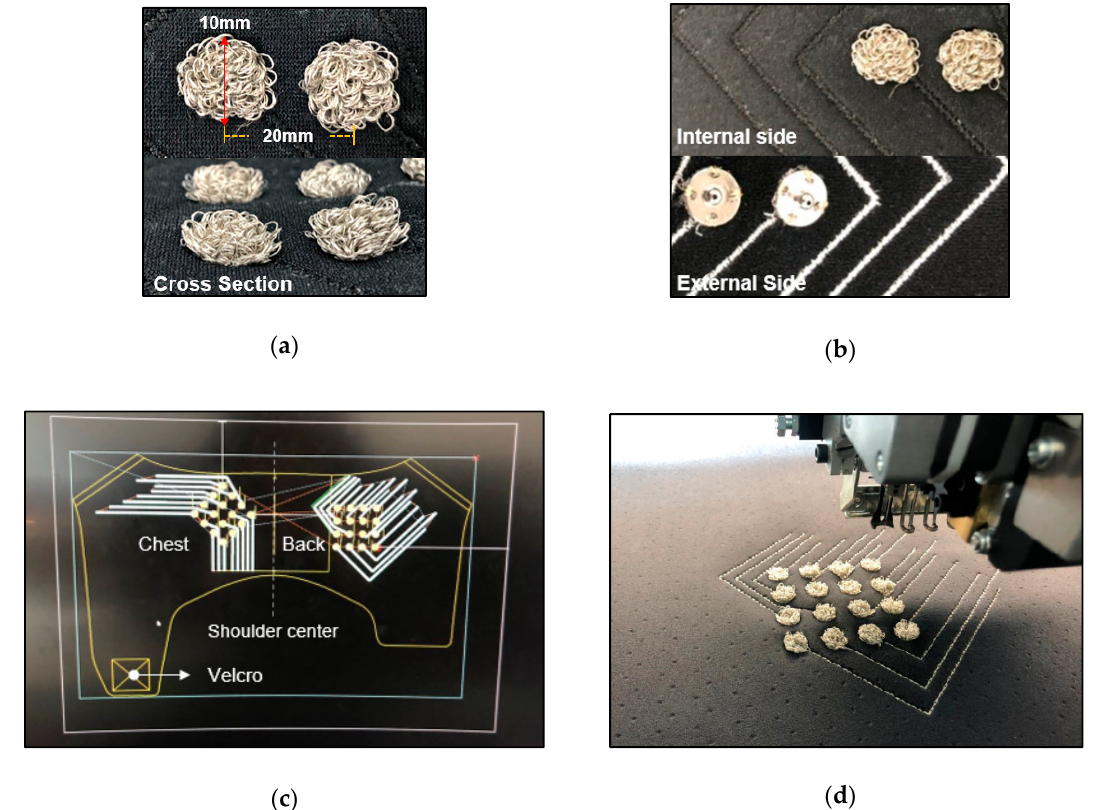
Figure 2. The proposed flexible socket part of fabric vest socket. ( a ) Size of the embroidered textile electrodes; ( b ) internal embroidered textile electrodes and external conductive path; ( c ) two-dimensional (2D) CAD drawing of the flexible socket; and ( d ) fabrication of the embroidered textile electrodes.